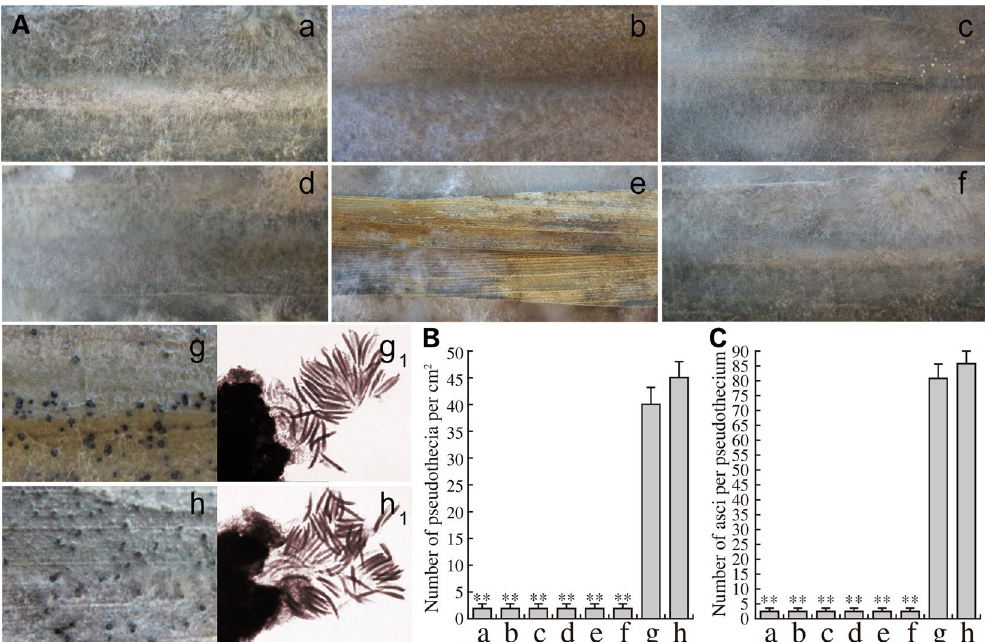
Figure 4. Effect of transformation of C. heterostrophus MAT genes on pseudothecia and asci formation in U. botrytis . ( A ) Pseudothecia formation was tested in different crosses or self matings on the surface of corn leaf substrates. ( B ) Average number of pseudothecia per square centimeter on the surface of the corn leaf. Error bars indicate 95% confidence intervals. No significant differences were observed in the number of pseudothecia between W1 and W2 ( P > 0.05). ( C ) Average number of asci per pseudothecium. At least 10 pigmented pseudothecia were opened and the number of asci in each pseudothecium were recorded. Error bars indicate 95% confidence intervals. No significant differences were observed in the number of asci per pseudothecium between WT1 and WT2 ( P > 0.05). a Cross-mating pattern DmUbMAT-1 { ChMAT } -1-1 ×